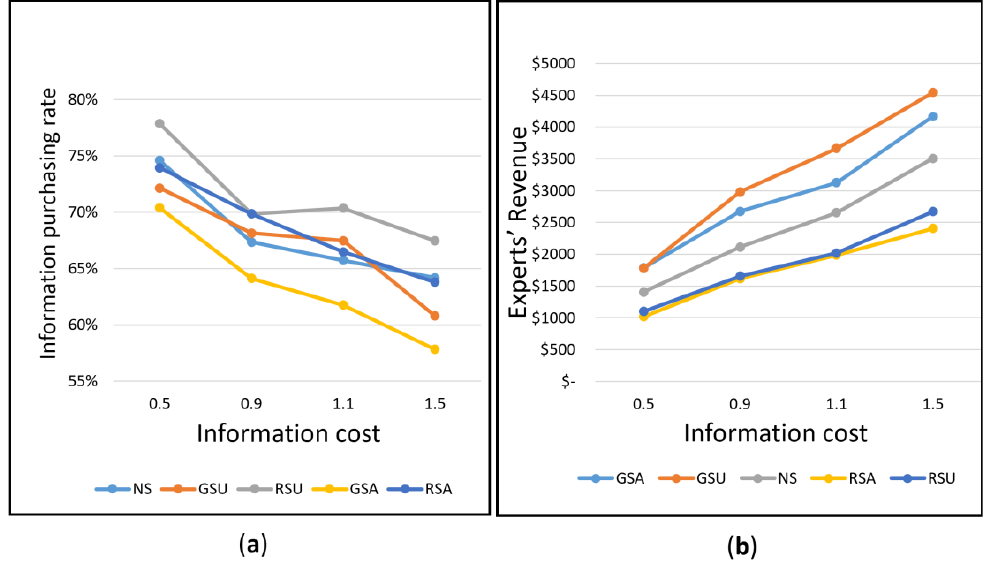
Figure 7. ( a ) Information purchasing rate as a function of the information cost. ( b ) Experts’ revenue as a function of the information cost.